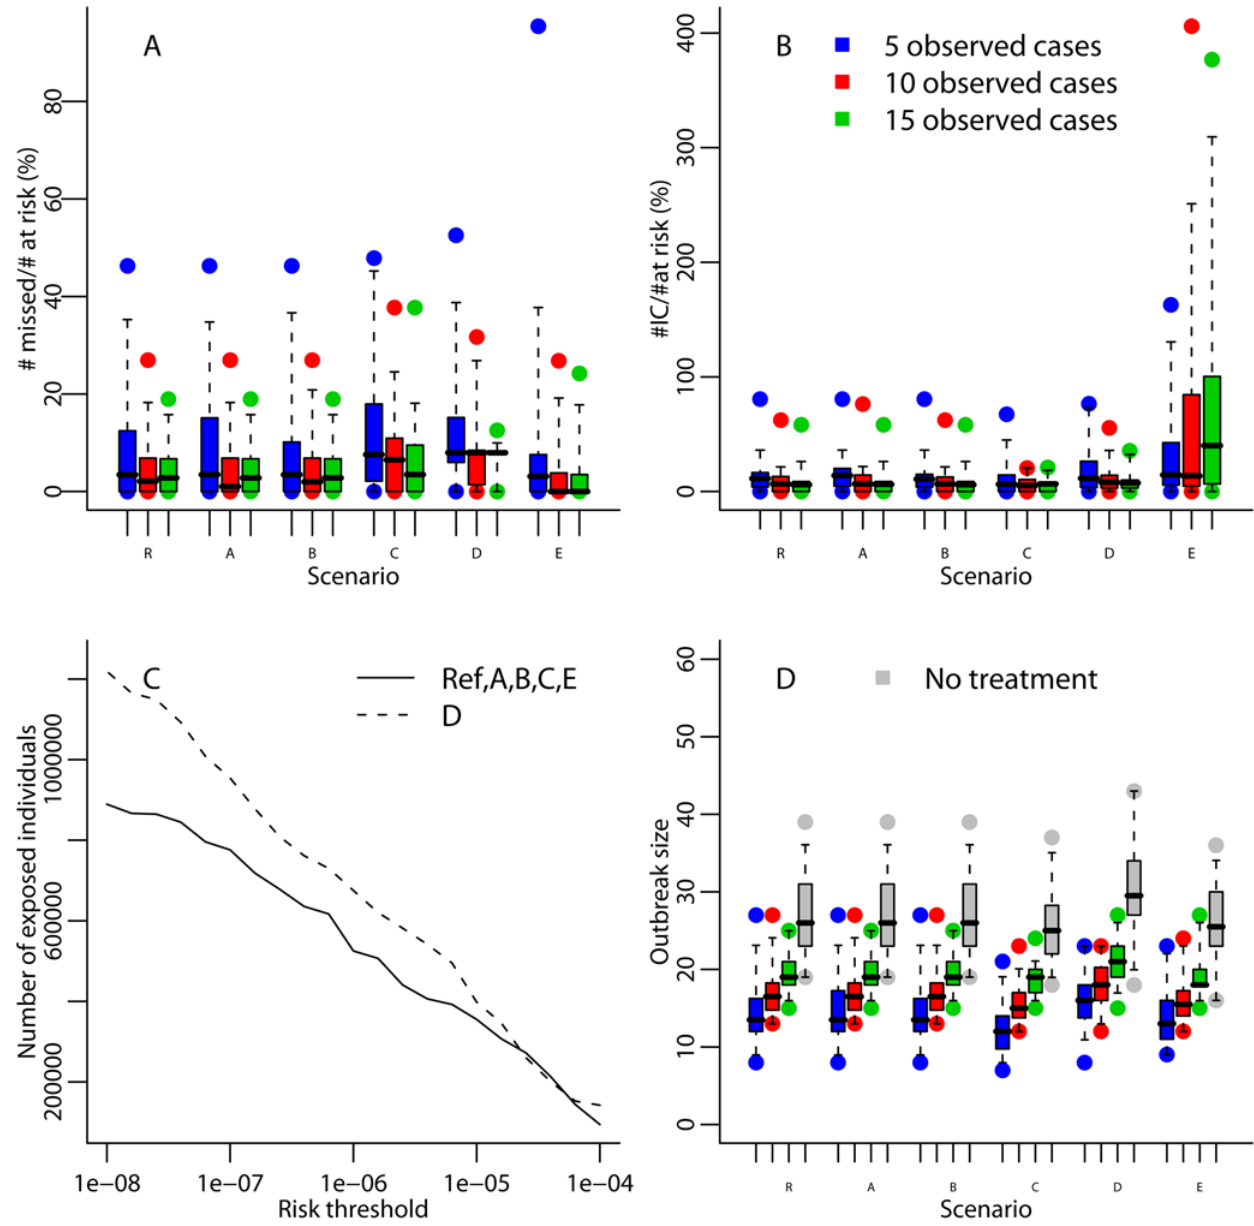
Figure 5. Impact of the targeting mitigation strategy with Reference scenario (R) and scenarios A to E. (A) Ratio of the number of individuals missed by the targeting mitigation strategy for a risk threshold of 1/100,000 relative to the theoretical number of individuals at risk. (B) Ratio of the number of individuals inaccurately targeted by the mitigation strategy for a risk threshold of 1/100 000 relative to the theoretical number of individuals at risk. (C) Number of individuals at risk according to the model used to generate the data. (D) Impact of administrating treatments to individuals living or working in a ward exposed to a risk of at least 1/100 ,000 inhabitants: outbreak size when there is no treatment and when prophylactic treatment compliance and efficacy is 100% prior to the onset of symptoms and administered 4 days after the first 5, 10 or 15 cases occurred. Each box-plot represents the distribution (minimum, maximum, percentiles 2.5, 25, 50, 75, 97.5) of the total number of cases.